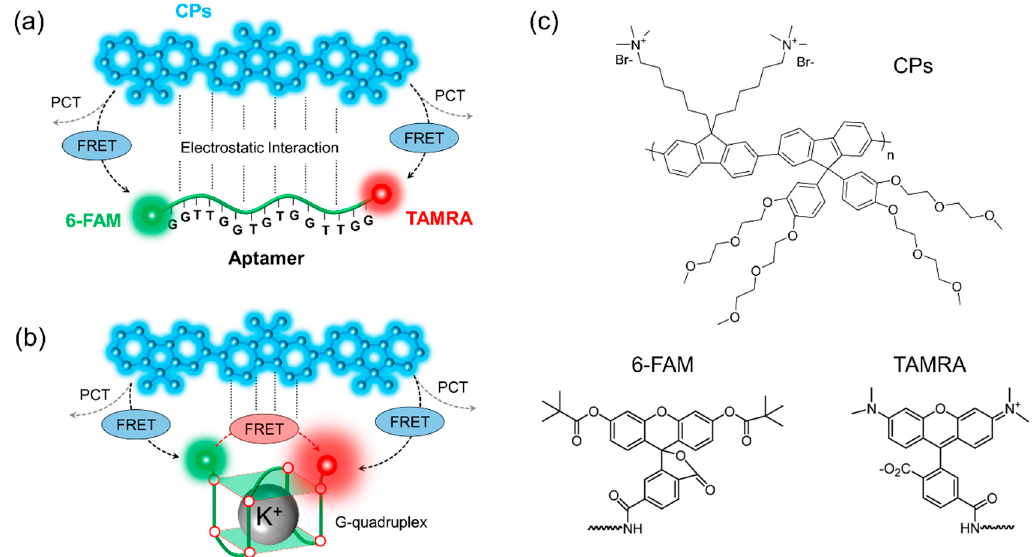
Figure 1 . Schematics for potassium detection based on FRET. ( a ) In the absence of K + ions, the dominant energy transfer process occurs from CPs to 6-FAM or TAMRA, that is, one-step FRET; ( b ) In the presence of K + ions, by preferred molecular interaction between metal ions and guanine bases, the secondary structure (g-quadruplex) leads to the sequential energy transfer from CPs to 6-FAM to TAMRA, that is, two-step FRET; ( c ) The chemical structure of CPs, 6-FAM, and TAMRA.